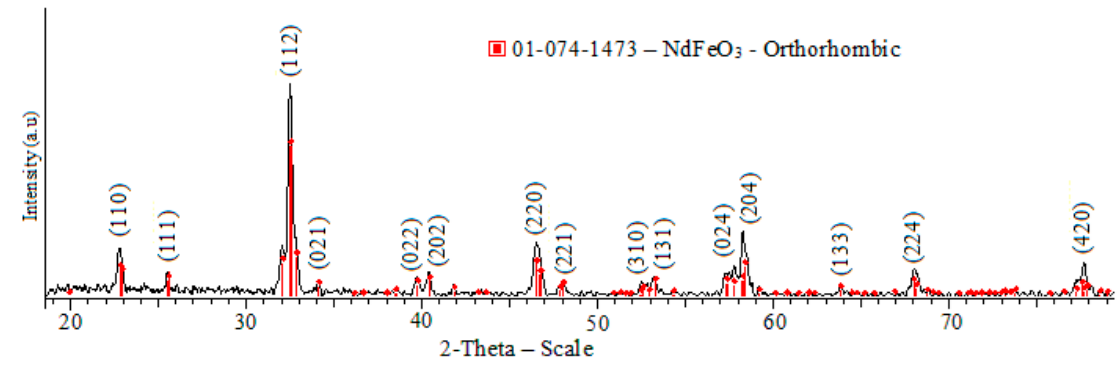
Figure 4. XRD patterns of NdFeO 3 formed at 750 °C. Table 1. Lattice parameters and magnetic properties of crystalline NdFeO 3 particles annealed at 750 °C.